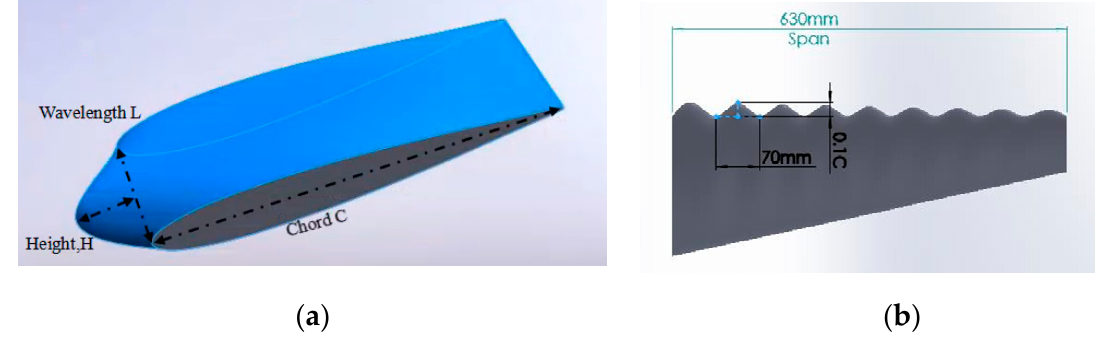
Figure 2. Sketch of ( a ) one leading-edge sinusoidal tubercle and ( b ) 3D blade with 9 tubercles ( H = 0.1 C 0 ( s ) , model H10N9).